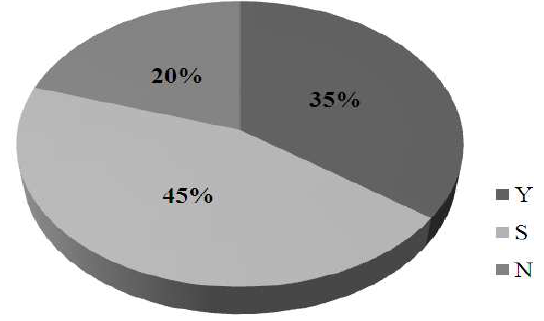
Fig. 12. Resource